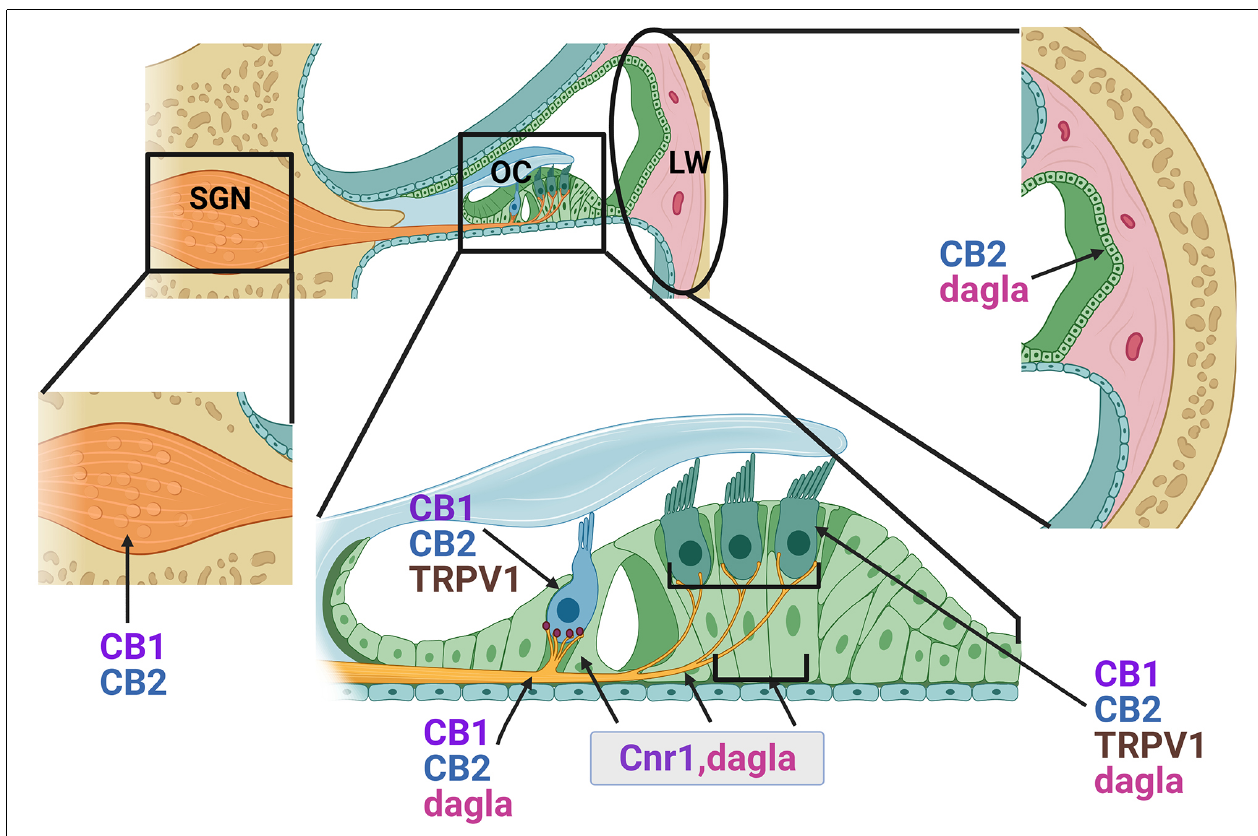
FIGURE 4 | Distribution of endocannabinoid components in the adult cochlea. Based on immunohistochemical data and gene expression studies from previously published reports, CB1 and CB2 receptors (proteins) and CB1 transcripts ( Cnr1 ) are distributed in the outer hair cells (OHC), inner hair cells (IHC), lateral wall (LW) cells and spiral ganglion neurons (SGN, cell bodies, and axonal projections). Cnr1 transcripts were also found in the pillar cells (PC) and Dieter’s cells (DC). While CB2 receptors appear fairly widely distributed, immunolabeling suggested possible greater intensities of staining around the base of the IHCs where the SGN nerve fibers and the IHC ribbon synapses are located. Transcripts of D agla are expressed in the sensory HCs, PCs, Deiters cells (DC), and SGN. TRPV1 is expressed in both inner and outer